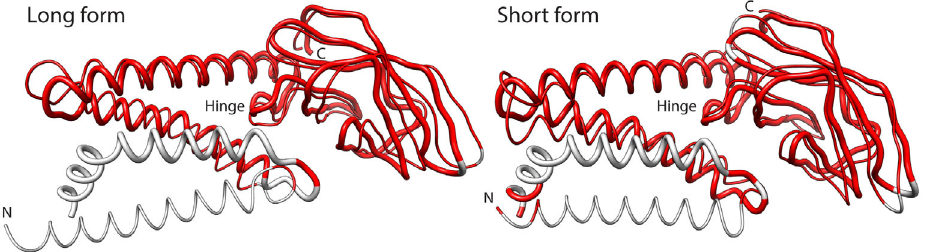
Figure 10. Alignment of long and short forms of the M-protein acquired by cryo-EM (thin backbones) to AlphaFold2 predicted structures (thick backbones). The superimposed regions with residues separated by distances less than 5 Å colored in